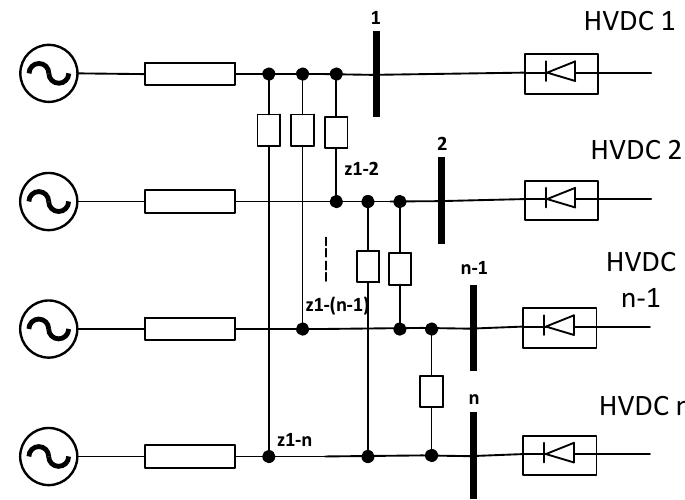
Figure 2. Chain-type multi-infeed HVDC system.